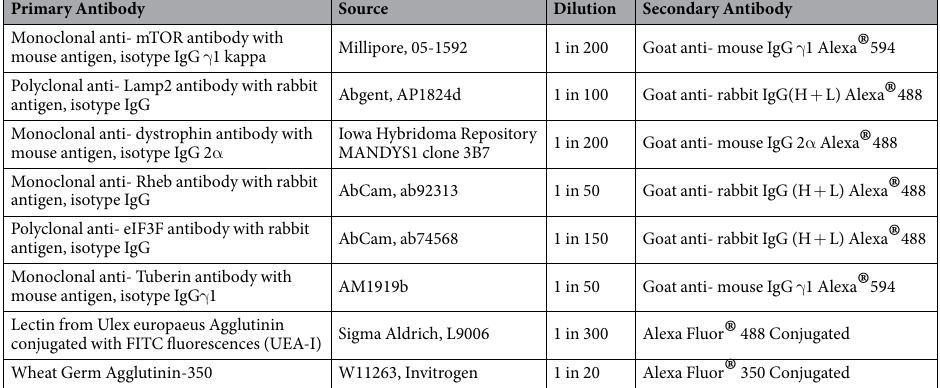
Table 1. List of primary and corresponding secondary antibodies used throughout the study. Antibody